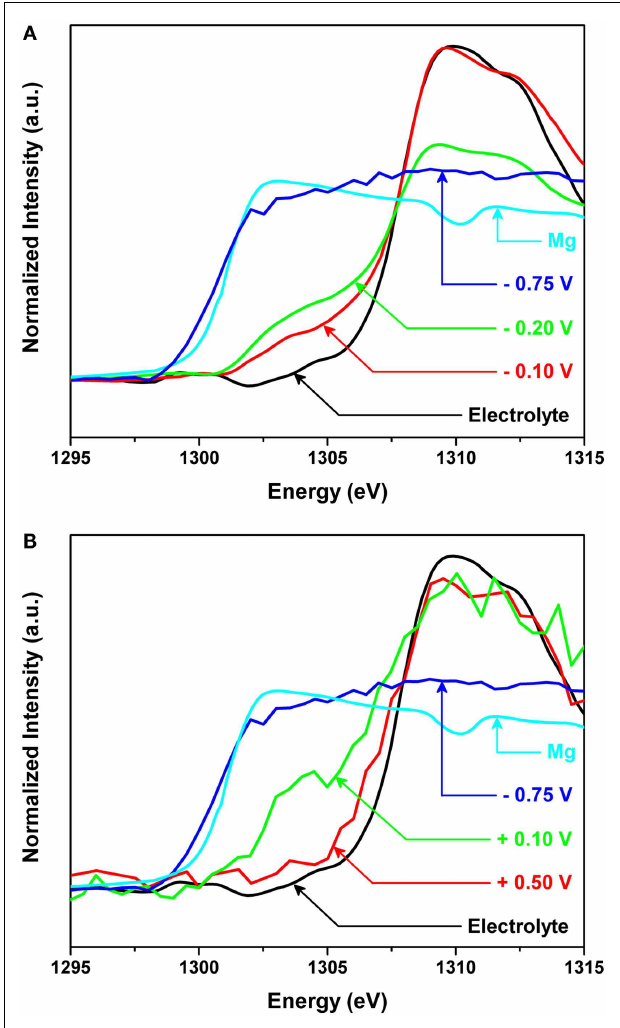
FIGURE 8 | In situ X-ray absorption near edge structure (XANES) spectra of the Mg K -edge for the interface between Mg metal and the organohaloaluminate electrolyte (A) during Mg deposition on a Pt electrode and (B) during Mg dissolution from the electrochemically deposited Mg metal onto the Pt electrode .The applied potentials were − 0.1, − 0.2, and − 0.75V vs. Mg for deposition and + 0.1 and + 0.5V vs. Mg for dissolution.